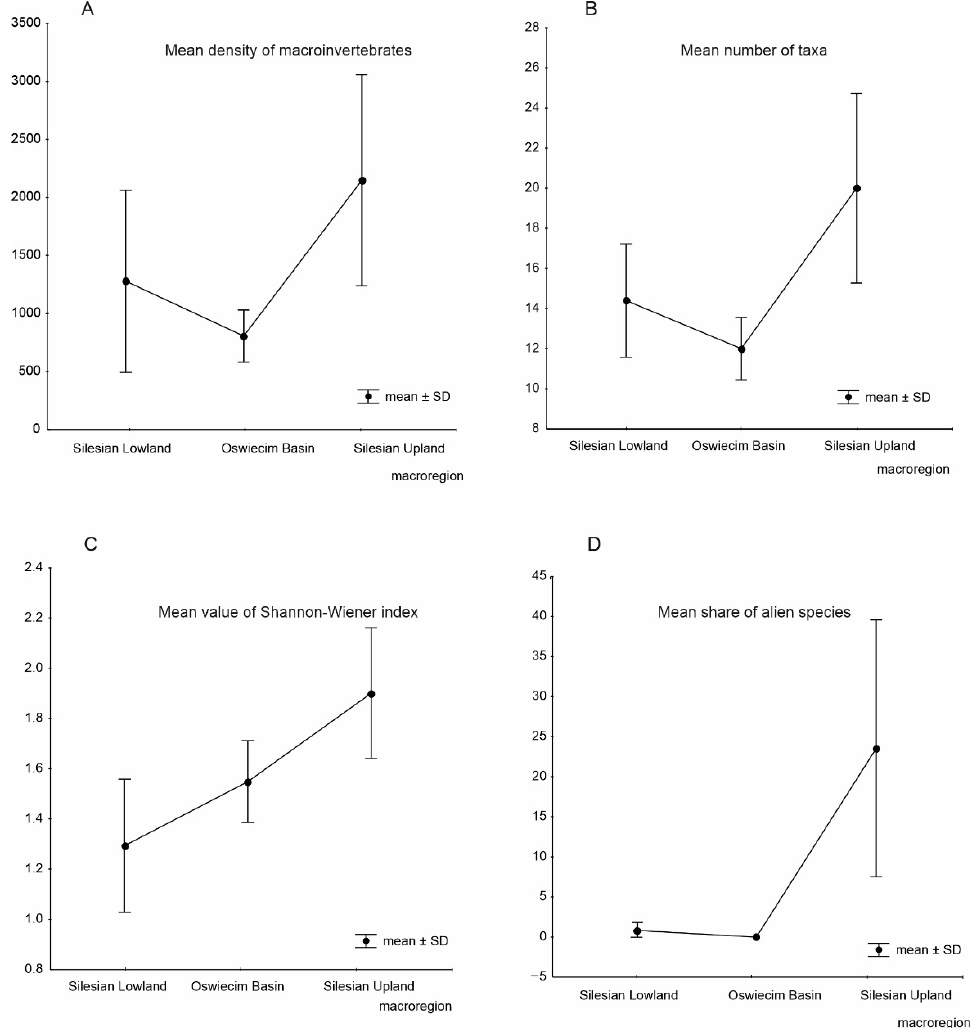
Figure 3. The mean density of benthic fauna ( A ), the mean number of macroinvertebrate taxa ( B ), mean value of the Shannon–Wiener index ( C ), and the mean proportion of alien species in benthic fauna ( D ) in water bodies from different geographical locations.